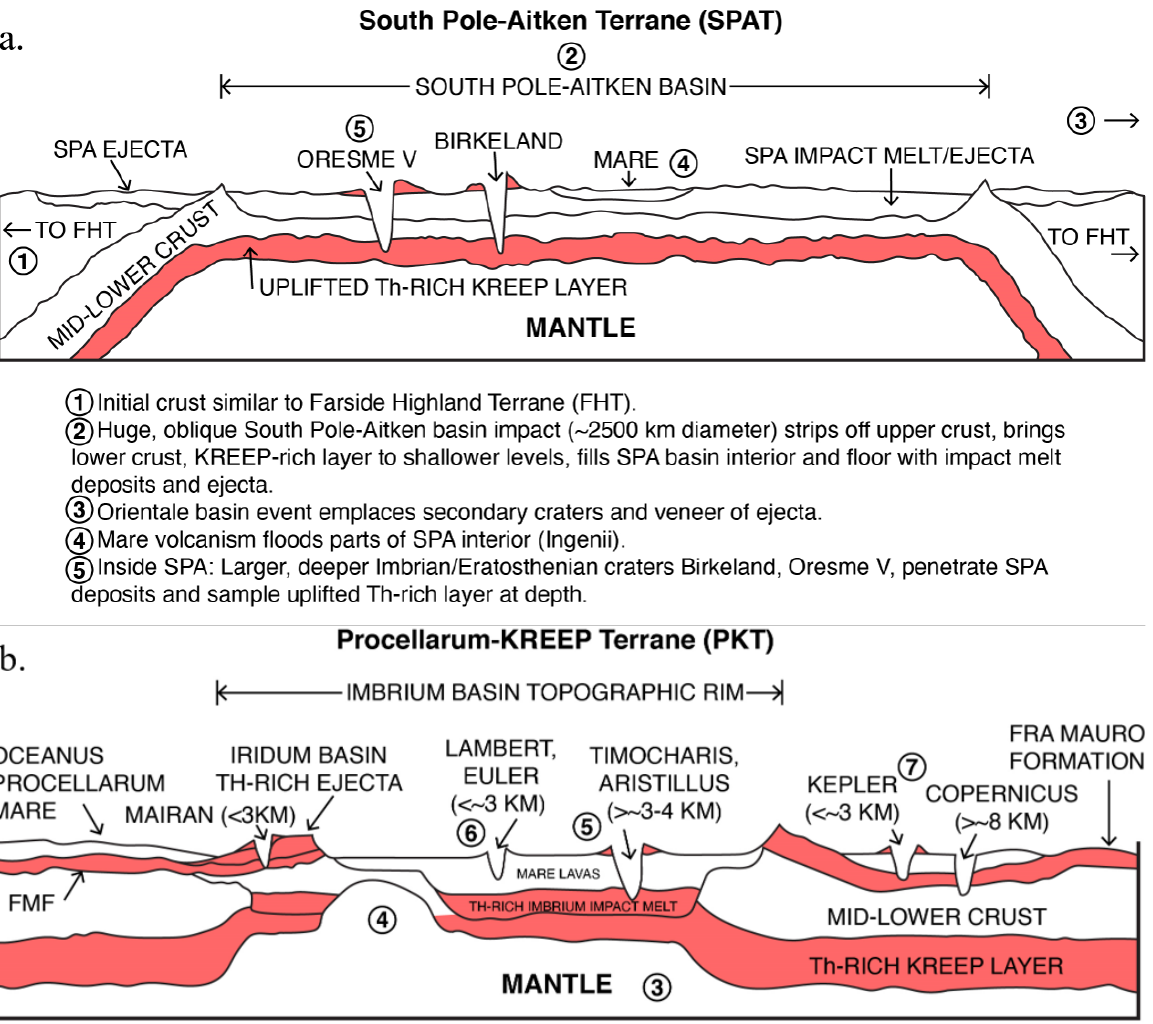
Figure 4. Reconstructed crustal cross-sections illustrating the sequence of impact events interpreted from crater/basin age and size in ( a ) South Pole–Aitken Terrane (SPAT; oblique, shallow excavation model) and ( b ) Procellarum KREEP Terrane (PKT). Compare crustal thickness and stratigraphy to original interpretation in Jolliff et al., 2000